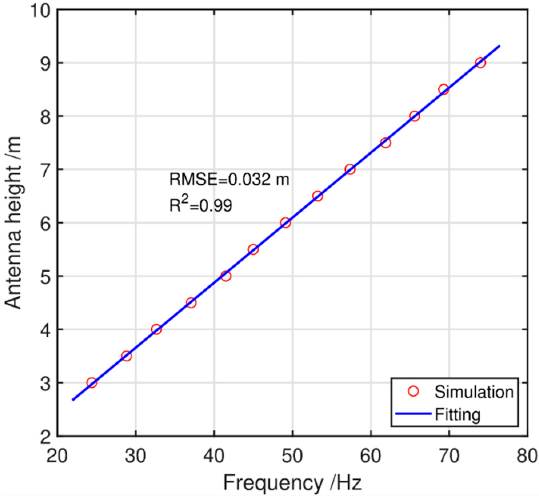
Figure 6. A linear model between the antenna height and frequency related to higher peak with the elevation angle range of 5°–20°. Herein, the parameters of a and b are given in Table 3. Table 3. Fitting coefficients calculated from the simulated arcs for different satellite